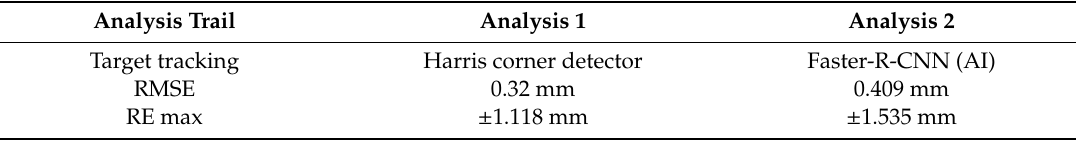
Table 4. The difference between the proposed monitoring system and LVDT measurements.